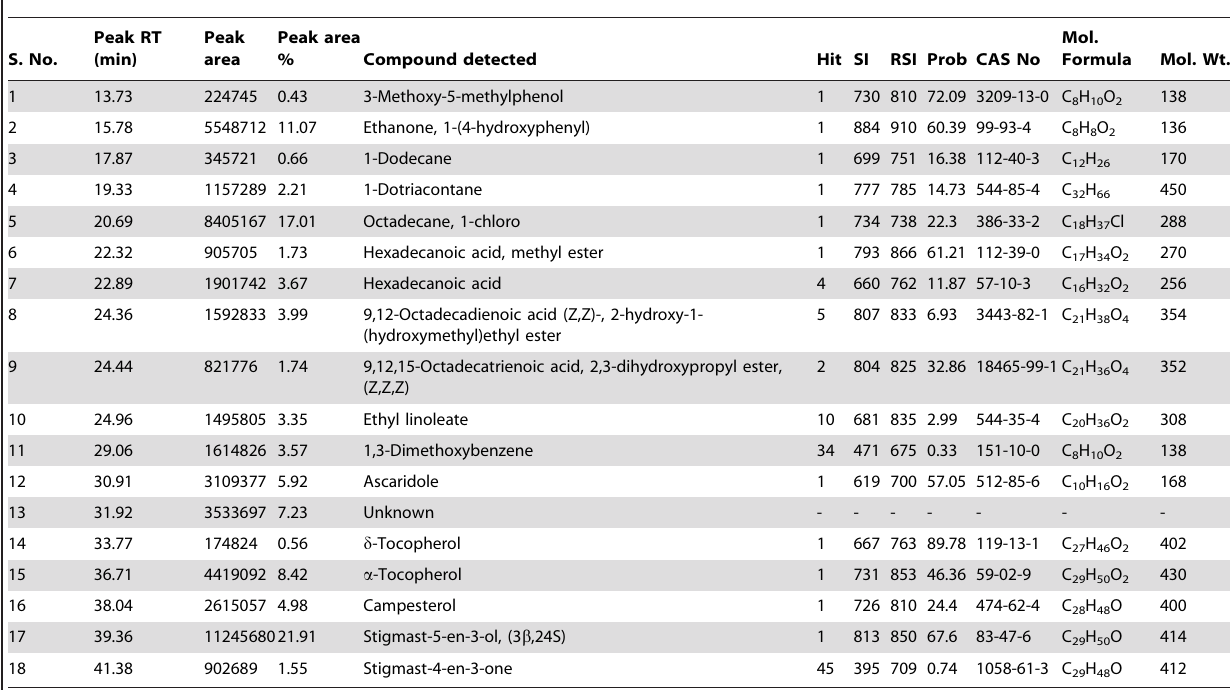
Table 5. Phyto-chemotypes identified in the methanol root extract of R. imbricata by GC/MS.